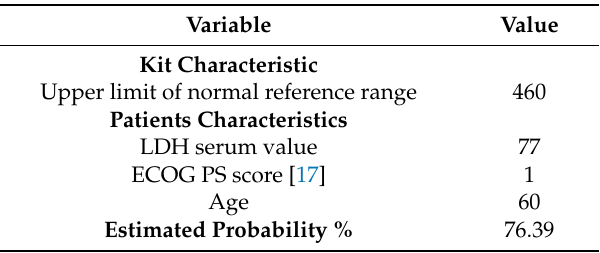
Table 3. Example of the excel interactive tool. Grey cells need to be filled; the blue one will show the estimated probability of clinical response.